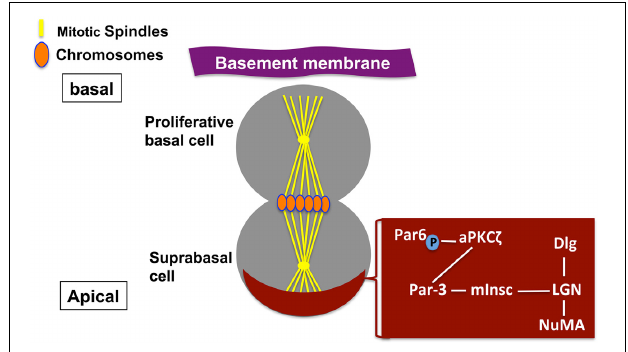
FIGURE 2 | Asymmetric cell division in mammalian epithelia. Schematic depiction of a polarized mammalian mother cell during mitosis (anaphase). Apical protein complexes are shown as a brown crescent. These apical protein complexes are important for both polarity establishment and spindle orientation in mammalian cells and are shown in a brown box, and described in the